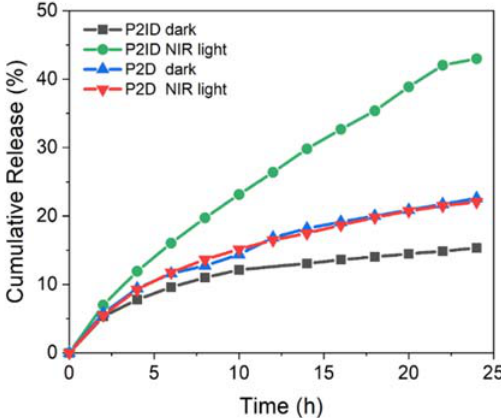
Figure 5. Cumulative DOX release from P2ID and P2D nanofibers in the absence and presence of NIR irradiation (0.78 W/cm 2 ).